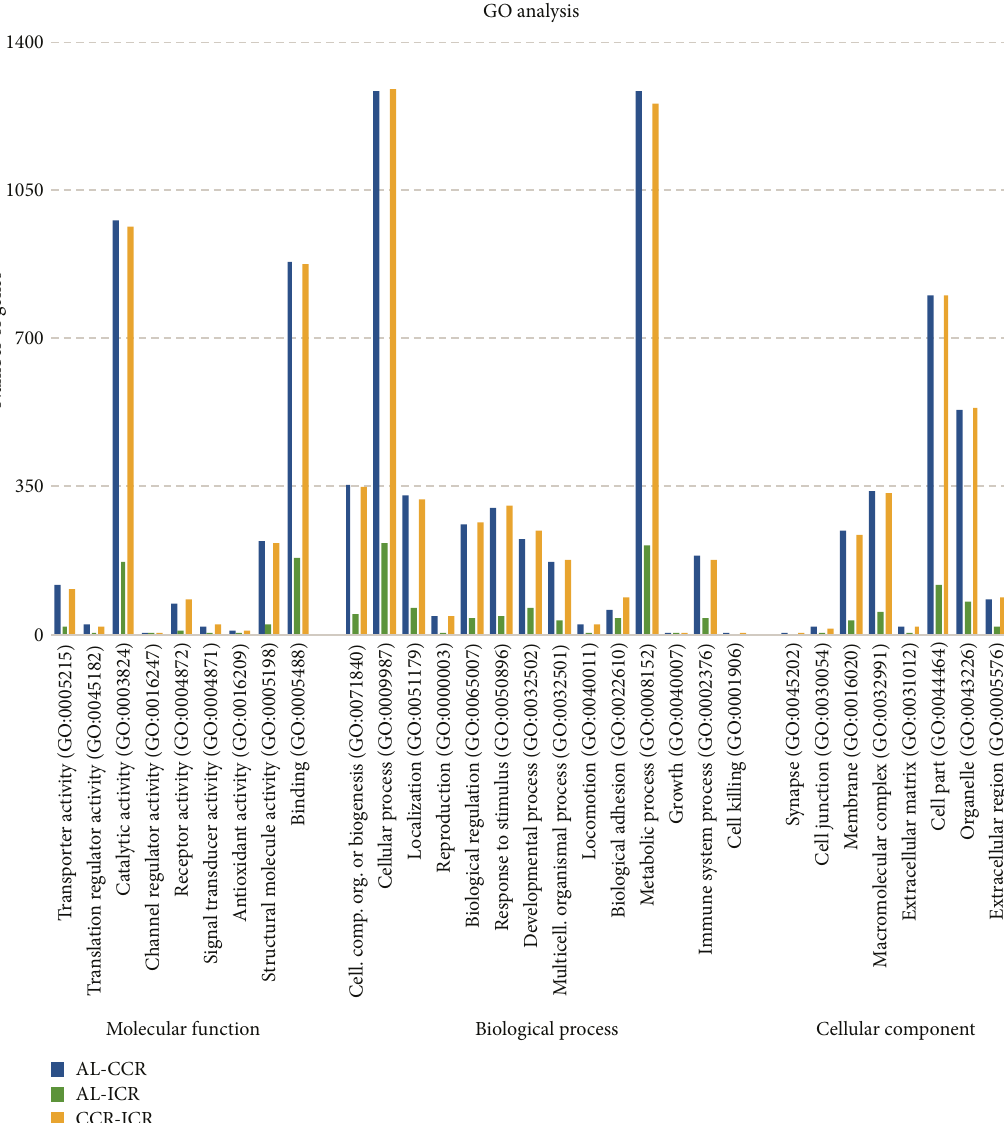
Figure 1: Clasi fi cations and numbers of DEGs into GO terms (AL-CCR: DEGs between AL and CCR; AL-ICR: DEGs between AL and ICR; and CCR-ICR: DEGs between CCR and